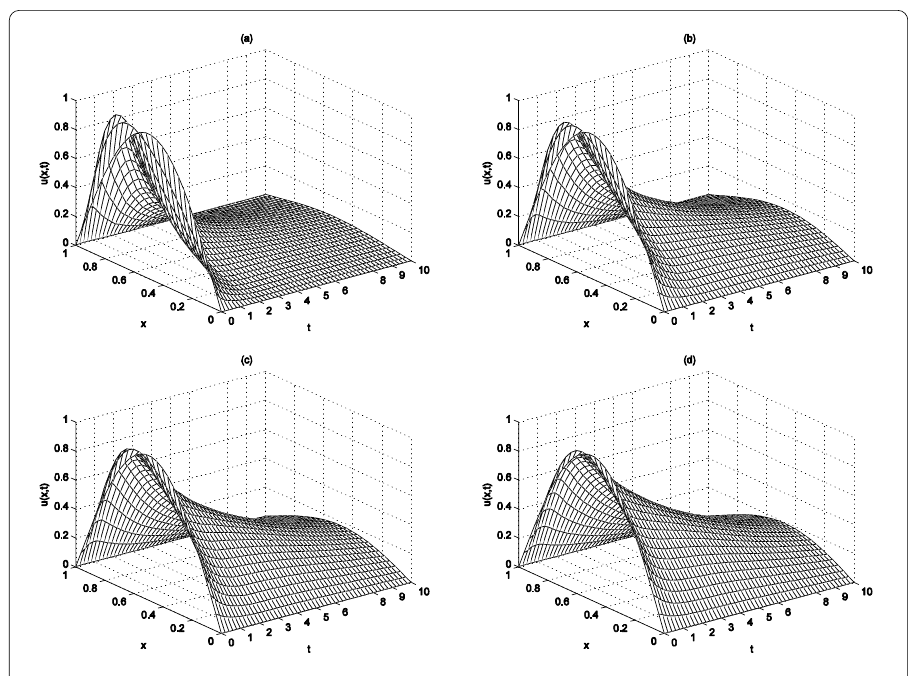
Figure 7 A 3-d landscape of the dynamics of the MGKdVB equation when using the second nonlinear non-adaptive control law; v = 0.01, μ = 0.001, γ 1 = 1, γ 2 = 0.0005 and u 0 ( x ) = sin( π x ); ( a ) α = 1; ( b ) α = 2; ( c ) α = 3; ( d ) α =